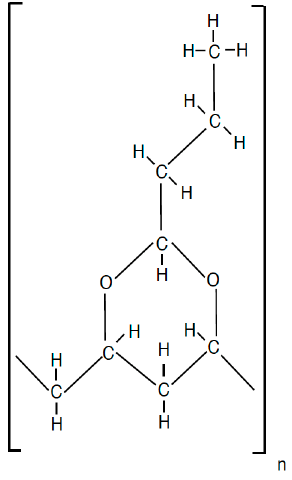
Figure 3. PVB chain structure.